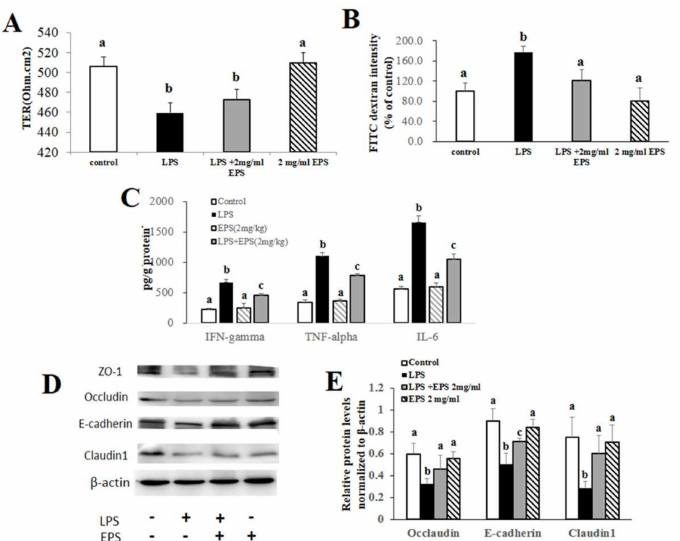
Figure 5. EPS-1 Protected intestinal barrier integrity from the disruption by LPS in Caco-2 monolayer. ( A ) The changes of transepithelial electrical resistance (TER) before and after treatment with LPS (10 µ g/mL) and/or EPS-1 (2 mg/mL) for 24 h in Caco-2 monolayer. ( B ) FITC-dextran (4 kDa) permeability measurement in 21-day cultured Caco-2 monolayer after LPS and/or EPS-1 treatment. ( C ) The levels of pro-inflammatory cytokines in the Caco-2 cells from each treatment group. ( D ) Protein expression of Occludin, E-cadherin and Claudin1 in the Caco-2 cells from each treatment group. ( E ) Relative protein levels of Occludin, E-cadherin and Claudin1 in Caco-2 cells normalized to β -actin. Values with different superscript letters (a, b, c) are significantly different ( p <